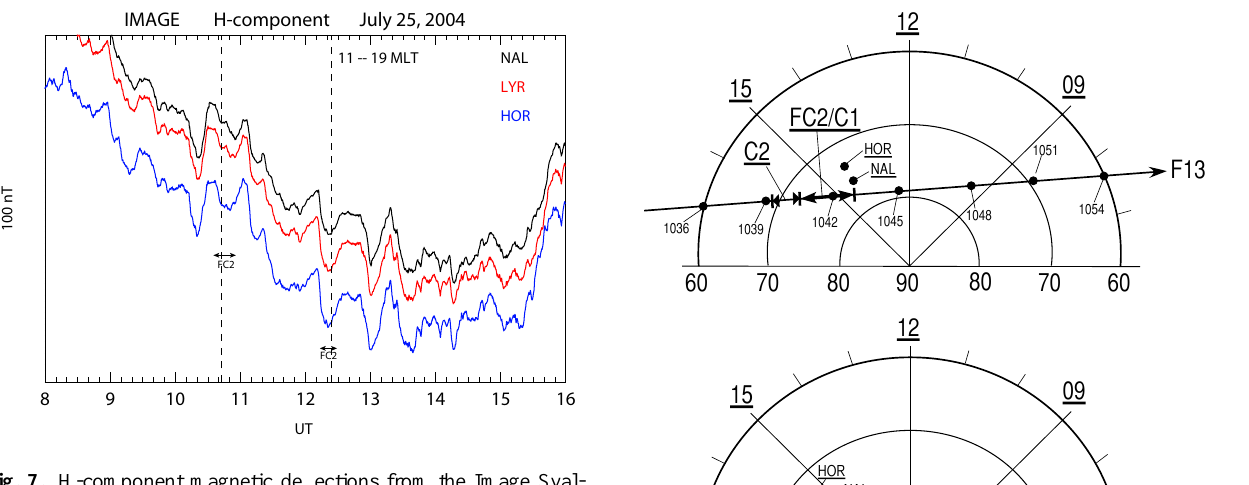
(inward-directed) and C2 (outward-directed) during the in- terval 10:39–10:43 UT are indicated along the track in the top